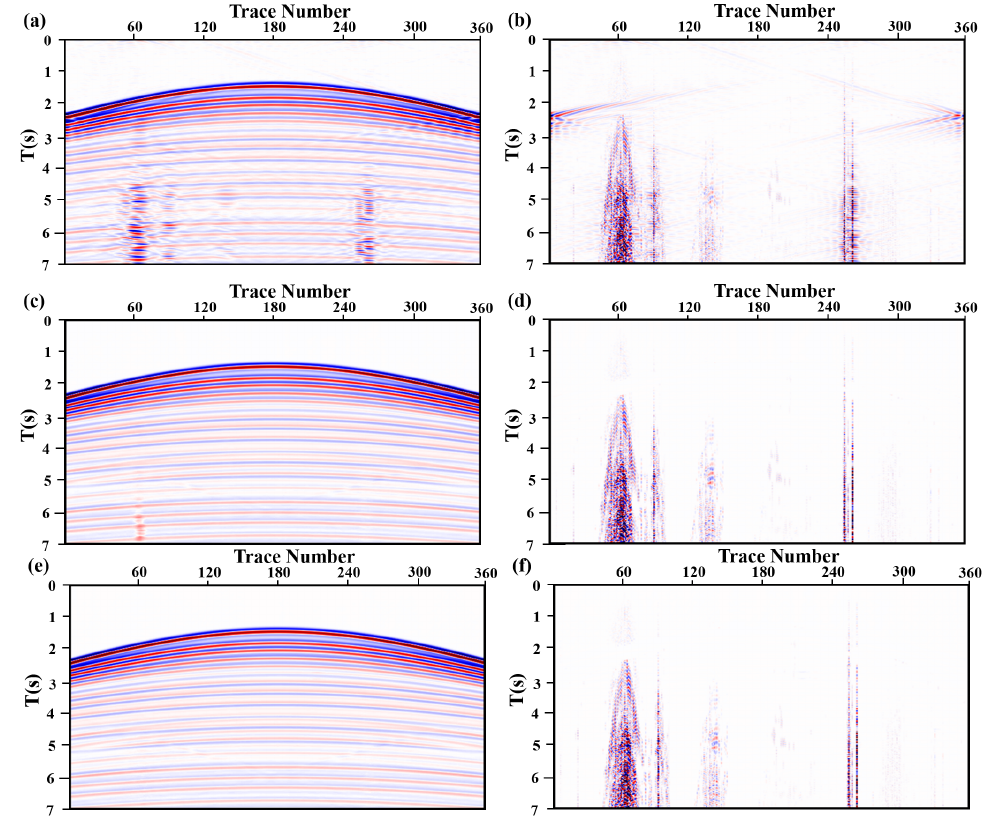
Figure 9. The denoising results and noise sections of different methods for synthetic data: ( a ) the denoising result and ( b ) noise section using f-k filtering; ( c ) the denoising result and ( d ) noise section using the UNet; ( e ) the denoising result and ( f ) noise section using the ACB-UNet.